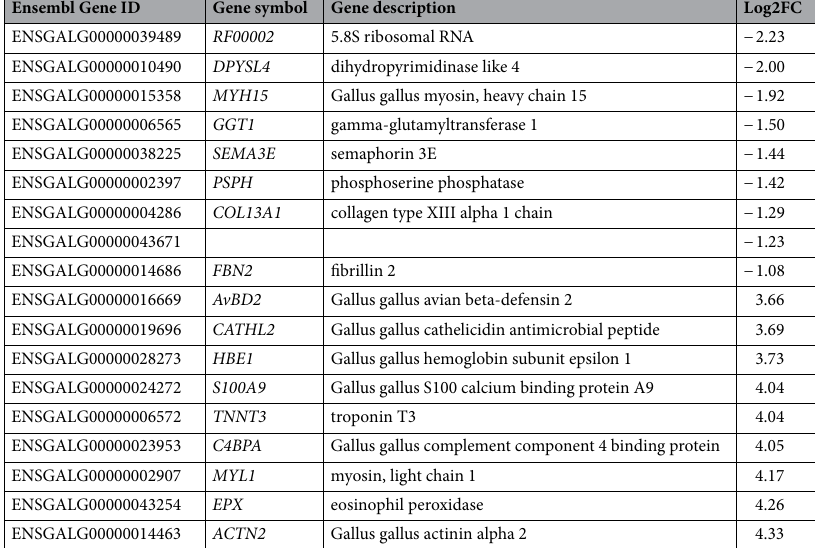
Table 2. Top 9 downregulated and upregulated differentially expressed genes in the articular cartilage between normal and FHS-affected broilers.